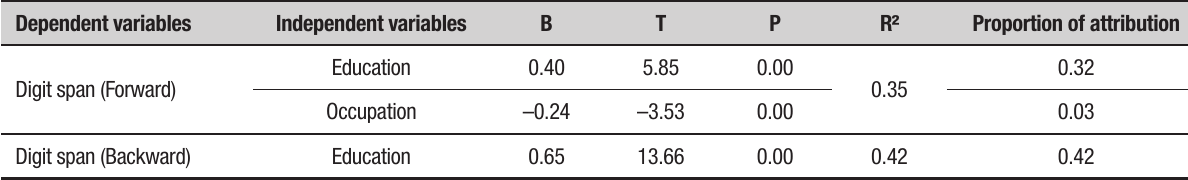
Table 3. Contribution of age, education and gender on Digit span.